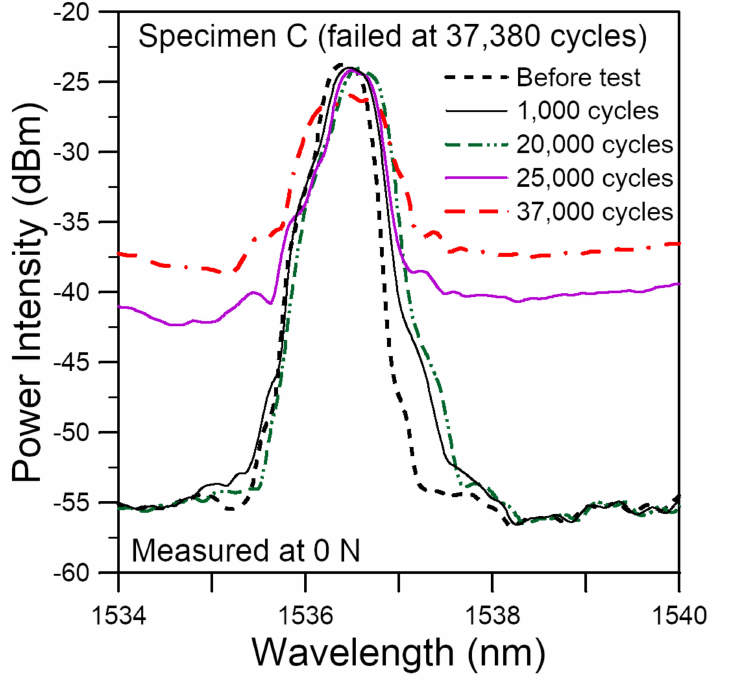
Figure 15. Evolution of typical unload FBG spectra during fatigue cycling of a specimen soaked at 60 ◦ C for 30